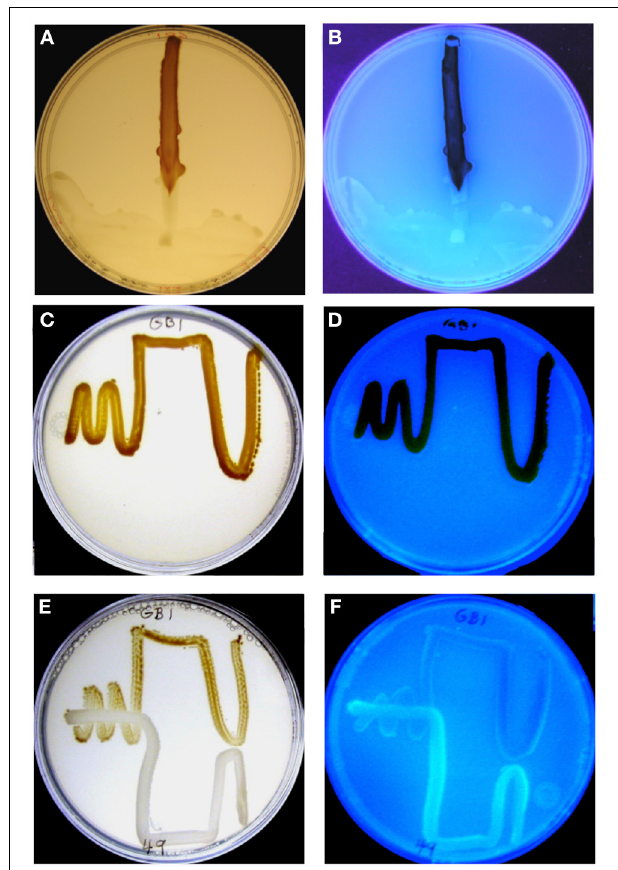
FIGURE 1 | MnO 2 formation by P. putida GB-1 after exposure to purified PVDGB-1 (A,B) and to PVD released during the growth of another siderotype n ◦ 1 strain, P. putida CFML90-49 (E,F). (A,C,E) Visible light illumination to show brown MnO 2 . (B,D,F) UV light illumination to detect blue-green PVD fluorescence. (A,B) Effect of 75 μ L of purified PVDGB-1 (200mM, siderotype n ◦ 1) applied at one edge of a plate containing 20ml of solid medium and a single streak of P. putida GB-1. The plate was incubated vertically so that the liquid remained localized, although it did spread as a crescent at the edge of the plate on the downward side, taking some inoculum with it. Note that areas of the strain GB-1 streak line near the zone of PVDGB-1 application showed considerable blue-green PVD fluorescence, whereas growth zones further from the PVD drop contained brown MnO 2 with no visible fluorescence. (C,D) Full MnO 2 production when strain GB-1 was cultured alone. (E,F) Inhibited MnO 2 production when strain GB-1 was co-cultivated with P. putida CFML90-49, which cannot oxidize Mn(II) and produces a siderotype n ◦ 1 PVD resembling PVDGB-1. Note the increased PVD fluorescence and decreased MnO 2 within strain GB-1 growth zones in the presence of strain CFML90-49 (E,F) as compared to the control without strain CFML90-49 (C,D) .